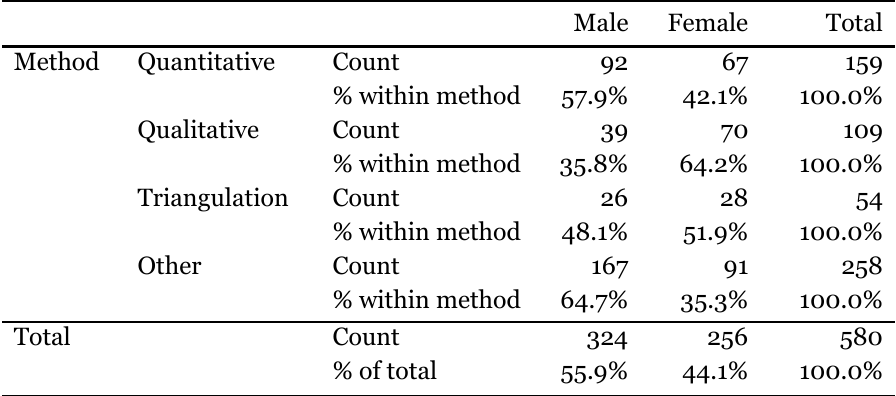
Cross Tabulation of Gender (First Author) and Research